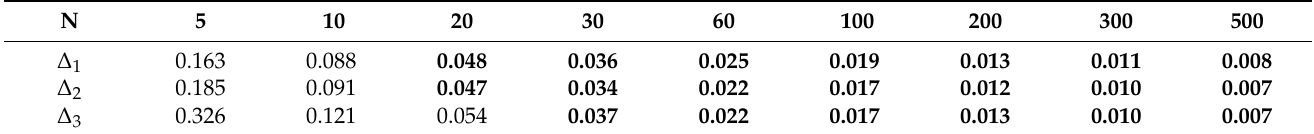
Table 2. Kolmogorov distances, comparing simulation results and asymptotic values for the total capacity of customers of different types for the QS MMPP ( ν ) |GI| ∞ . Bold format highlights results that do not exceed the value of the acceptable approximation threshold.